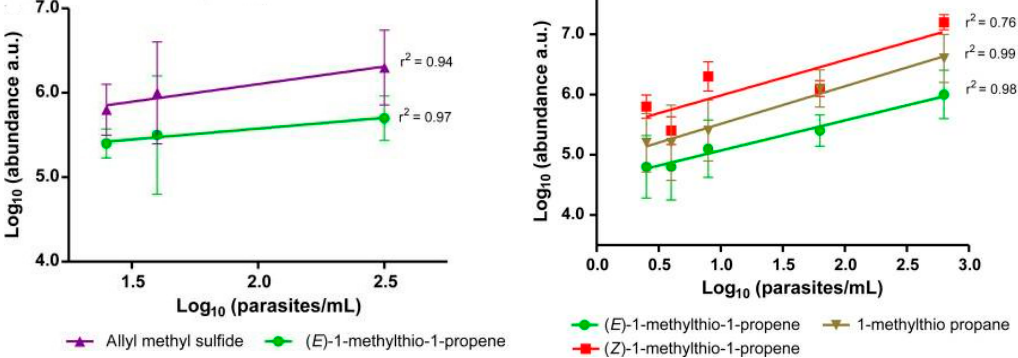
Figure 1. Correlation of identified malaria metabolites with parasite level in exhaled breath before and after antimalarial treatment with a fast-acting synthetic ozonide drug. Error bars show the standard deviation of the mean. (After Berna et al. [22]).